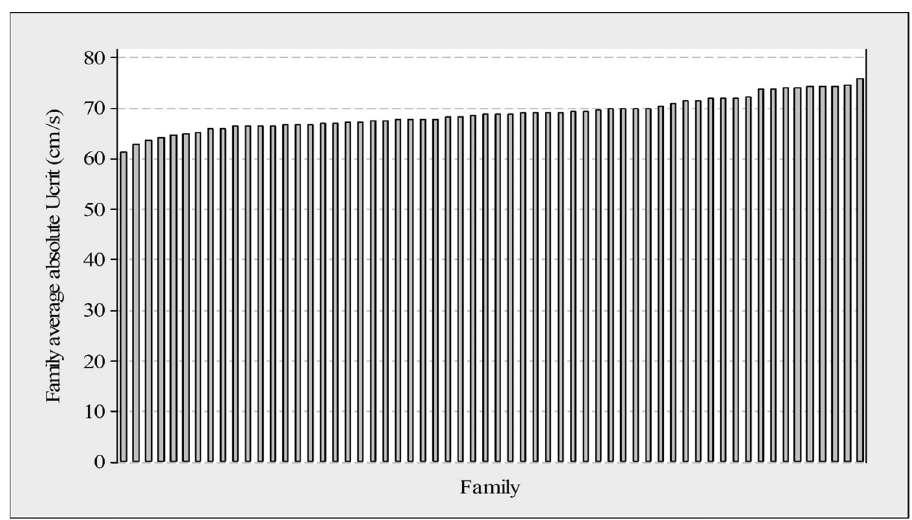
Figure 3. Histogram of family average absolute U crit (cm s −1 ) for each of the 60 families.